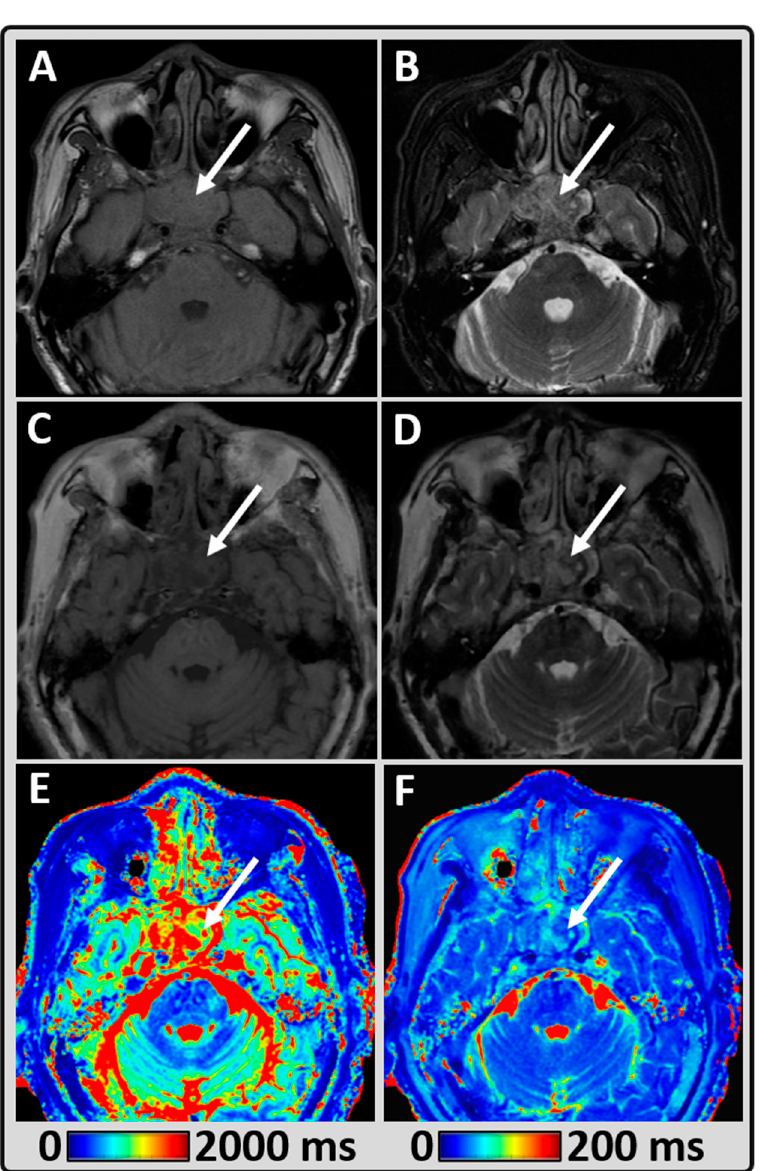
Figure 4. Representative MRI data from a 54-year-old male patient with white arrow pointing at recurrent nasopharyngeal cancer (post radiation therapy) extended to the sphenoid sinus. ( A , B ) Conventional qualitative pre-contrast T1w and T2w images depicting the lesion; ( C,D ) Synthetically generated T1w and T2w images using MAGiC; ( E , F ) MAGiC-generated quantitative T1 and T2 maps.